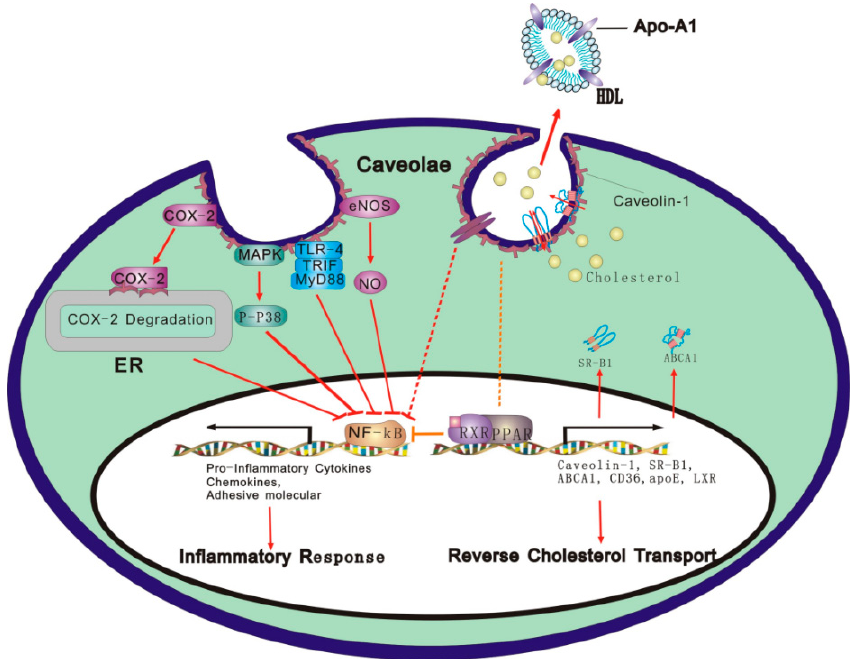
Figure 1. The primary mechanisms whereby caveolae/Cav-1 exerts its protective effects on inflammatory responses triggered by LPS or cytokines. On the one hand, Cav-1 binds to TLR4, eNOS, MAPK and COX-2, respectively, and initiates different signal pathways, resulting in the inhibition of NF- κ B transcriptional activity that blocks the expression of pro-inflammatory genes, such as TNF- α and IL-6. On the other hand, the cholesterol-export activity of Cav-1 may account for its potent anti-inflammation properties. PPAR γ may induce Cav-1 expression, enhance cholesterol efflux, and inhibit NF- κ B transcriptional activity, further suppressing LPS-induced inflammatory response. Red arrows: direct promotion or leading to subsequent result; dished lines: indirect inhibition.